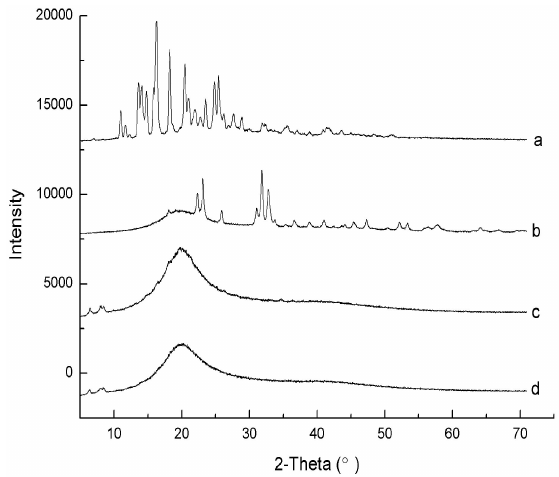
Figure 2. X-ray diffraction (XRD) patterns of astaxanthin ( a ), astaxanthin-loaded nanoliposomes ( b ), soybean phosphatidyl choline (SPC) ( c ) and physical mixture of astaxanthin and SPC ( d ).